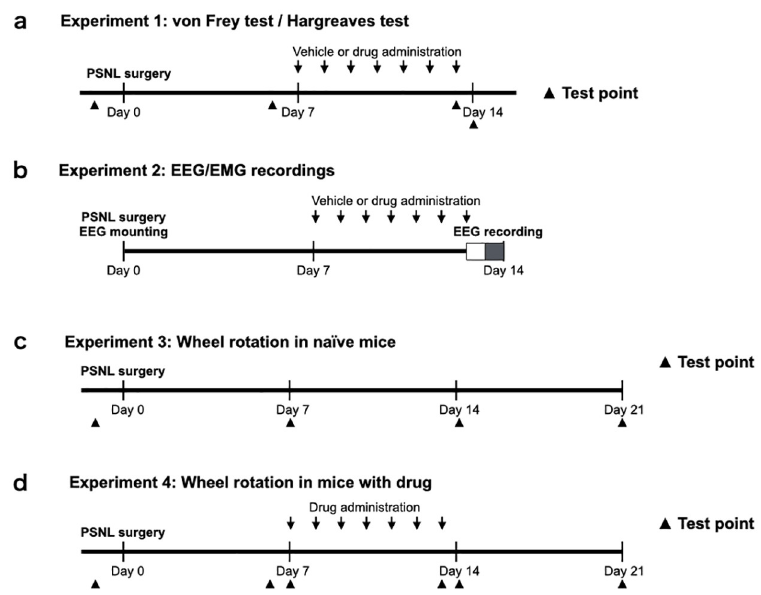
Fig 1. Experimental timeline. Mice were subjected to von Frey and Hargreaves tests at certain test points in Experiment 1 (a). They were treated with suvorexant (30 mg/kg, p.o.), mirtazapine (1 mg/kg, i.p.), or vehicles once daily at ZT 0 for 7 days after nerve ligation. Mice treated with suvorexant or mirtazapine were subjected to EEG for 24 h in Experiment 2 (b). The number of wheel rotations was recorded in na ï ve mice 1 day before PSNL surgery and at 7, 14, and 21 days after surgery in Experiment 3 (c). The number of wheel rotations was recorded in the mice treated with suvorexant or mirtazapine at the test points in Experiment 4 (d). Abbreviations: ZT, Zeitgeber time; PSNL, partial sciatic nerve ligation; EEG,